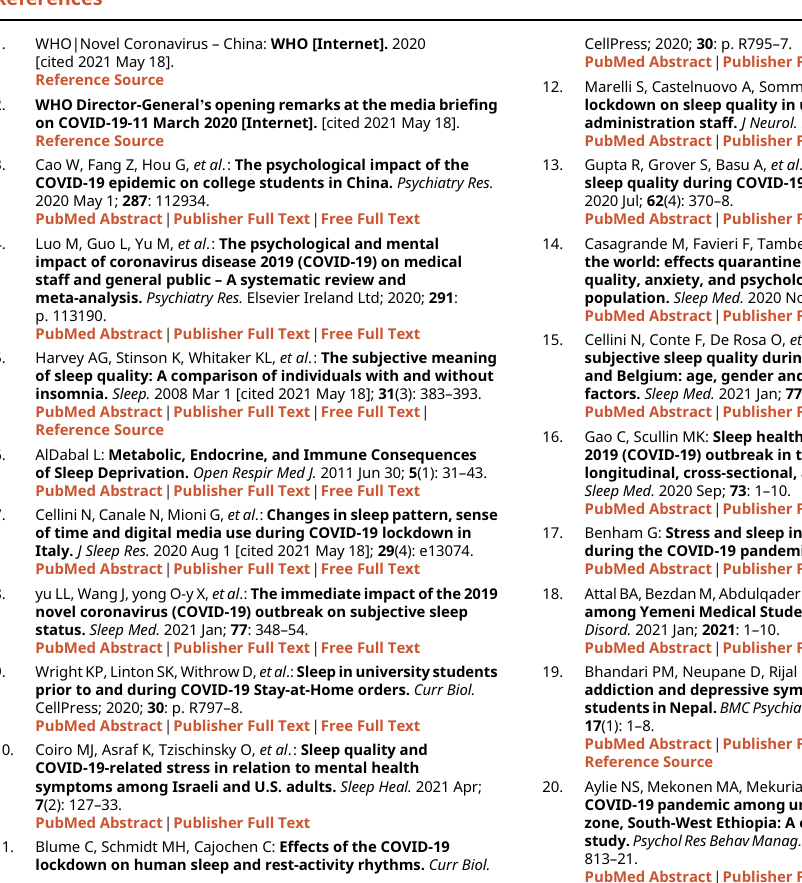
Figshare. Sleep quality among undergraduate students of a medical college in Nepal during COVID-19 pandemic: an online survey. DOI: https://doi.org/10.6084/m9.figshare.14770182.v2. 34 Data are available under the terms of the Creative Commons Zero “ No rights reserved ” data waiver (CC BY 4.0 Public domain